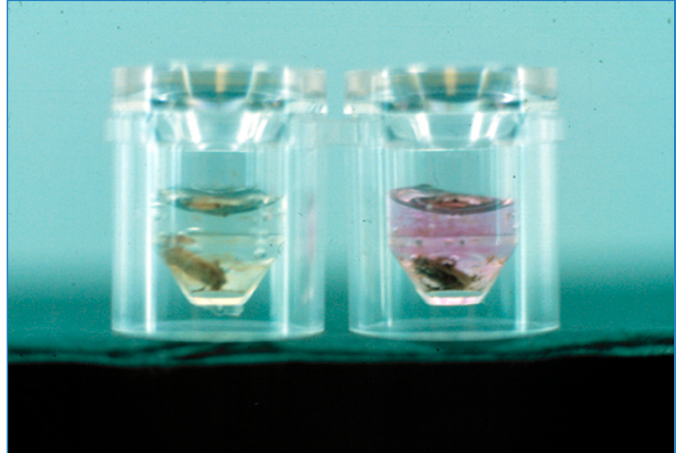
Figure 1. Colorimetric assay of biotinidase activity. On the left, no or straw-colored development of a one-eighth-inch-diameter blood-soaked filter paper spot from a child with profound bioitinidase deficiency compared to the mauve color development in a sample from a child with normal biotinidase activity. The colorimetric assay was performed in plastic, disposable cups that were inserted into a modified Guthrie template tray. Initially, individuals with putative bioitinidase deficiency were identified by observation comparing color development with a series of control samples with those having 25%, 50% 75% and 100% of normal activity.